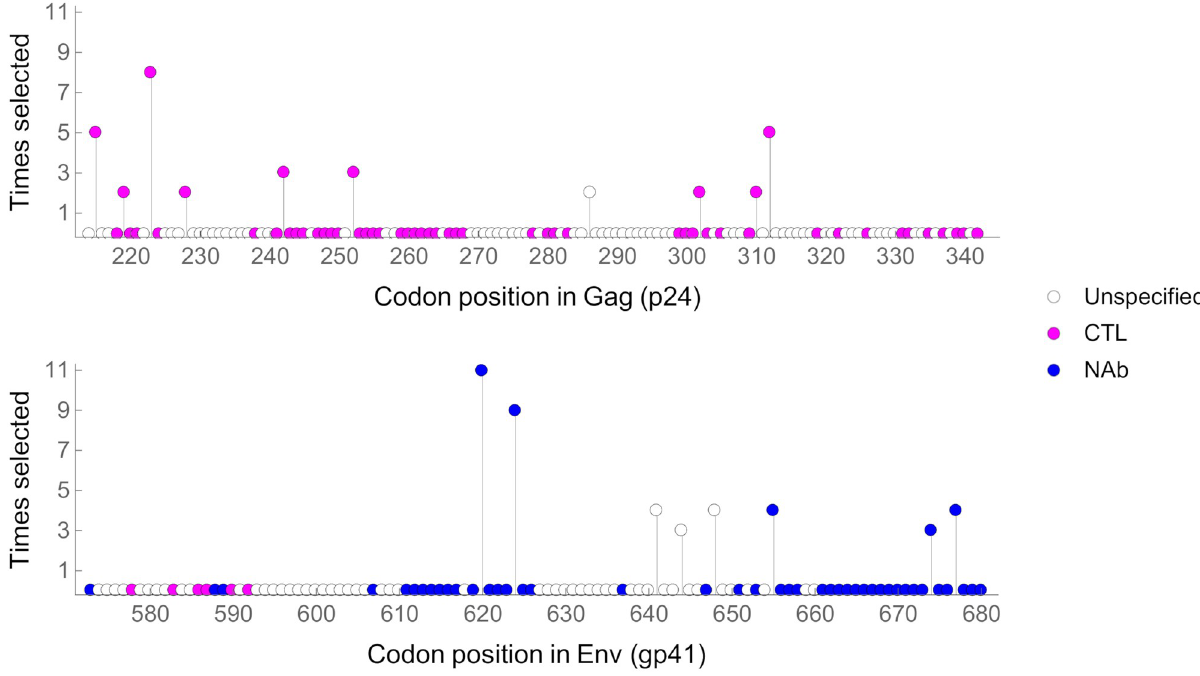
Fig 4. Amino Acid (AA) positions containing nucleotide sites that with confidence were inferred to be under selection in at least one individual. Codon positions are in relation to the HXB2 reference sequence and the vertical y-axis gives the number of times that codon was inferred to be under selection across 34 individuals. Occasionally the same AA position was inferred to be under selection twice in the same individual. Pink: AA positions associated with changes in susceptibility to CTLs or compensatory mutations; Blue: AA positions associated with susceptibility to NAbs. Selection at Gag residue 286 possibly reflects CTL escape in one individual and reversion in another. Selection at Env residues 641, 644, and 648 possibly reflect selection associated with NAbs; these are all within an epitope region targeted by the neutralising antibody HGF24 in some African Isolates[58]. Where an AA position is implicated in CTL and NAb responses, for clarity they are coloured in